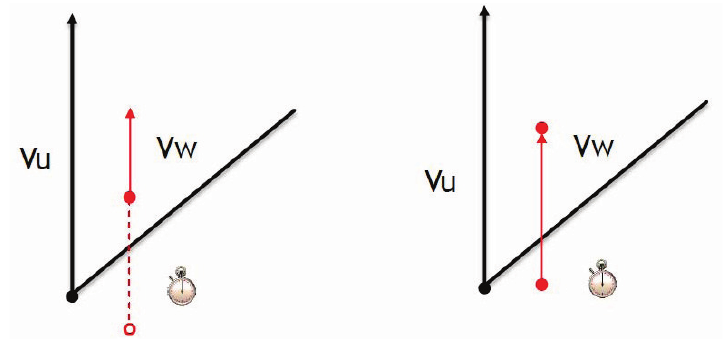
Figure 4. The timer implementation in the modified cone-based scheme: Vehicle w moves slower than vehicle u ( Left ); vehicle w moves faster than vehicle u ( Right